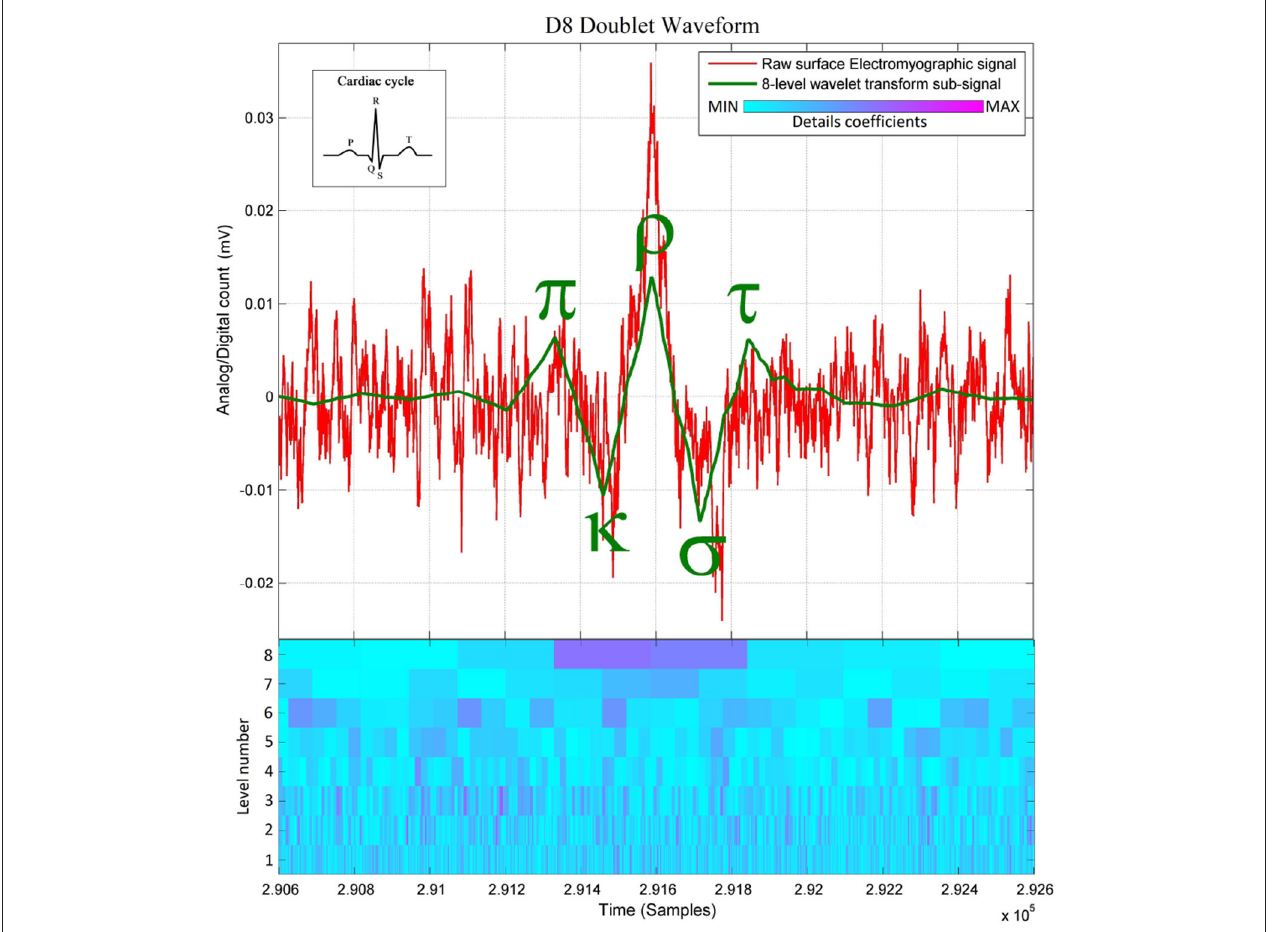
FIGURE 1 | Raw paraspinal surface electromyographic signal of a healthy individual, overlaid with its 8-level wavelet transformed sub-signal and its scalogram below (The level number in the scalogram corresponds to the scale of the discrete wavelet transform dwt of Matlab) . Note that the D8 doublet is a precise sequence of ( + ) peaks and ( − ) dips, defined here as the π - κ - ρ - σ - τ sequence because of its similarity with the cardiac cycle. The concordance between the D8 and the burst here appears naturally without preprocessing. Observe the two D8 coefficients indicating rapid succession of 2